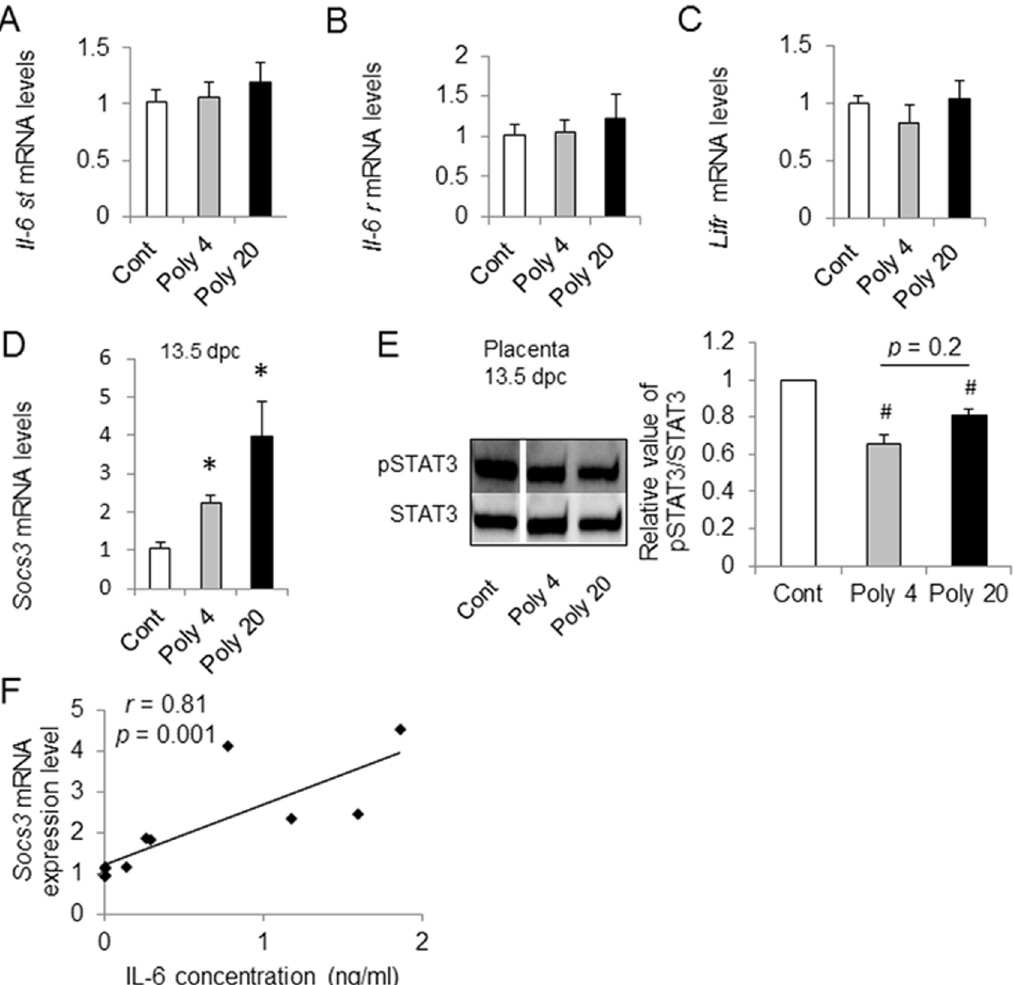
Fig 5. Maternal immune activation (MIA) induced changes of placental gp130 related cytokines gene expression and JAK/STAT3 signaling. (A) Expression of Il-6st . (B) Expression of Il-6r . (C) Expression of Lifr . (D) Expression of suppressor of cytokine signaling 3 ( Socs3 ) at 13.5 days post-coitum (dpc). (E) Analysis of STAT3 phosphorylation at 13.5 dpc. (F) Correlation of suppressor of cytokine signaling 3 ( Socs3 ) mRNA expression and maternal interleukin-6 (IL-6). Placental Socs3 expression was upregulated with the polyriboinosinic-polyribocytidylic acid [poly (I:C)] dosage. polyriboinosinic- polyribocytidylic acid [poly (I:C)] at 12.5 dpc, placenta were analysed 3 h after the injection (A, B, C). Expression of Socs3 and the activation of JAK2/STAT3 signaling were analysed 24 h after the injection (D and E). Controls, Poly 4 and Poly 20 were blotted in the same membrane (E). Maternal IL-6 in control was not detected and is represented as Zero in the Fig (F). Controls were injected with an equal volume of saline (0.01 ml/g body weight). #, p < 0.01. * , p < 0.05. Number of dams = 3 or 4 in each group, two foetuses were collected as a pooled sample from each litter. Error bars ,